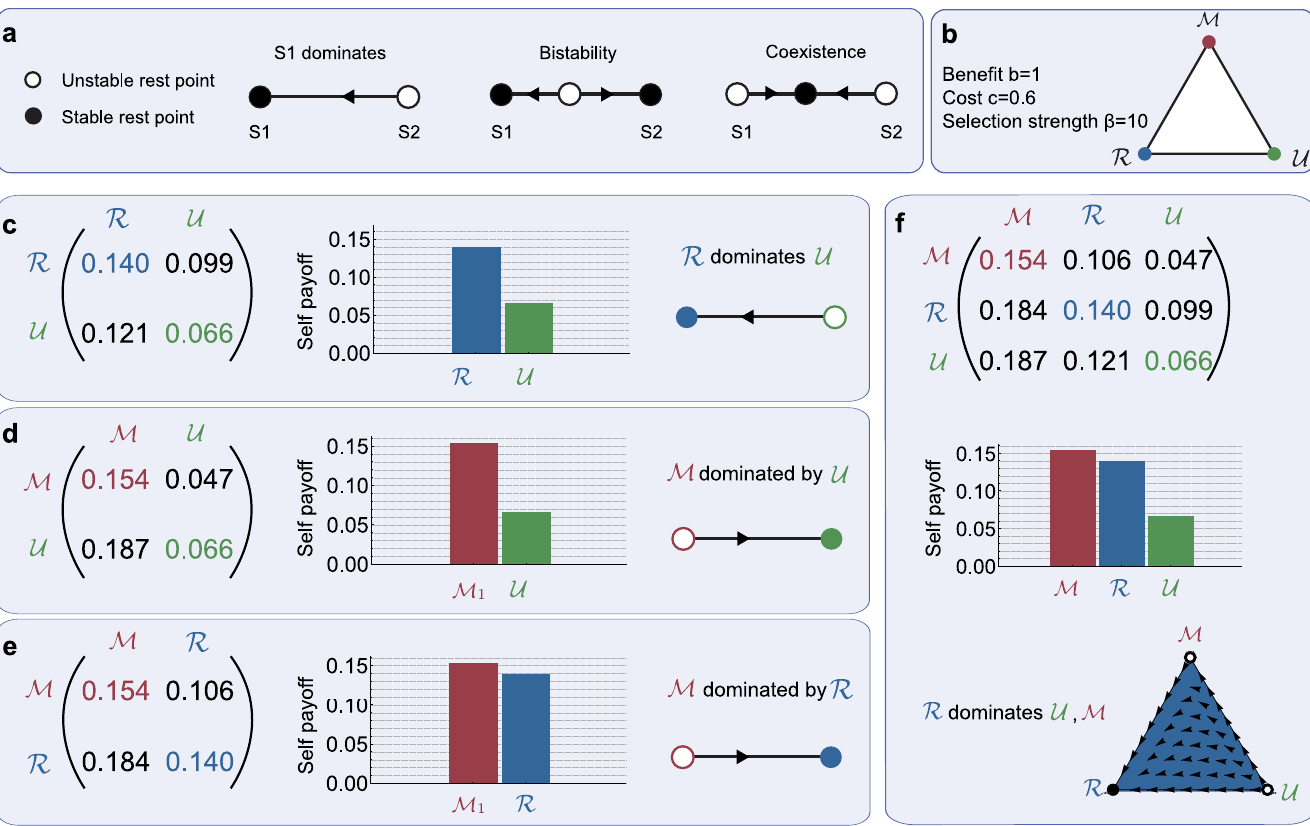
Fig 3. Evolutionary dynamics of memory spaces. To explore the evolution of different memory capacities, we use replicator dynamics [50]. Members of a population can have one of three different memory spaces, memory-1 ( M ), reactive ( R ), or unconditional ( U ). The fraction of population members with a given memory space changes in time, depending on whether players with this memory space obtain an expected payoff above average. a , When only two memory spaces compete, there are three possible dynamics: either one space is globally stable (dominance), each space is locally stable (bistability), or the two spaces form a stable mixture (coexistence). b , Here we illustrate our approach by considering an environment in which cooperation is comparably costly and where selection is relatively weak. c-e , We first analyze the replicator dynamics for each pair of memory spaces. We find that in a pairwise competition, R dominates both U and M , whereas U dominates M . f , In a next step, we study the replicator dynamics among all three memory spaces. For the given parameter values, we find that R is globally stable: independent of the initial composition of the population, all trajectories lead towards a monomorphic population of reactive players. Overall, we obtain a ‘memory dilemma’: the memory space that evolves is not the memory space that maximizes the population’s average